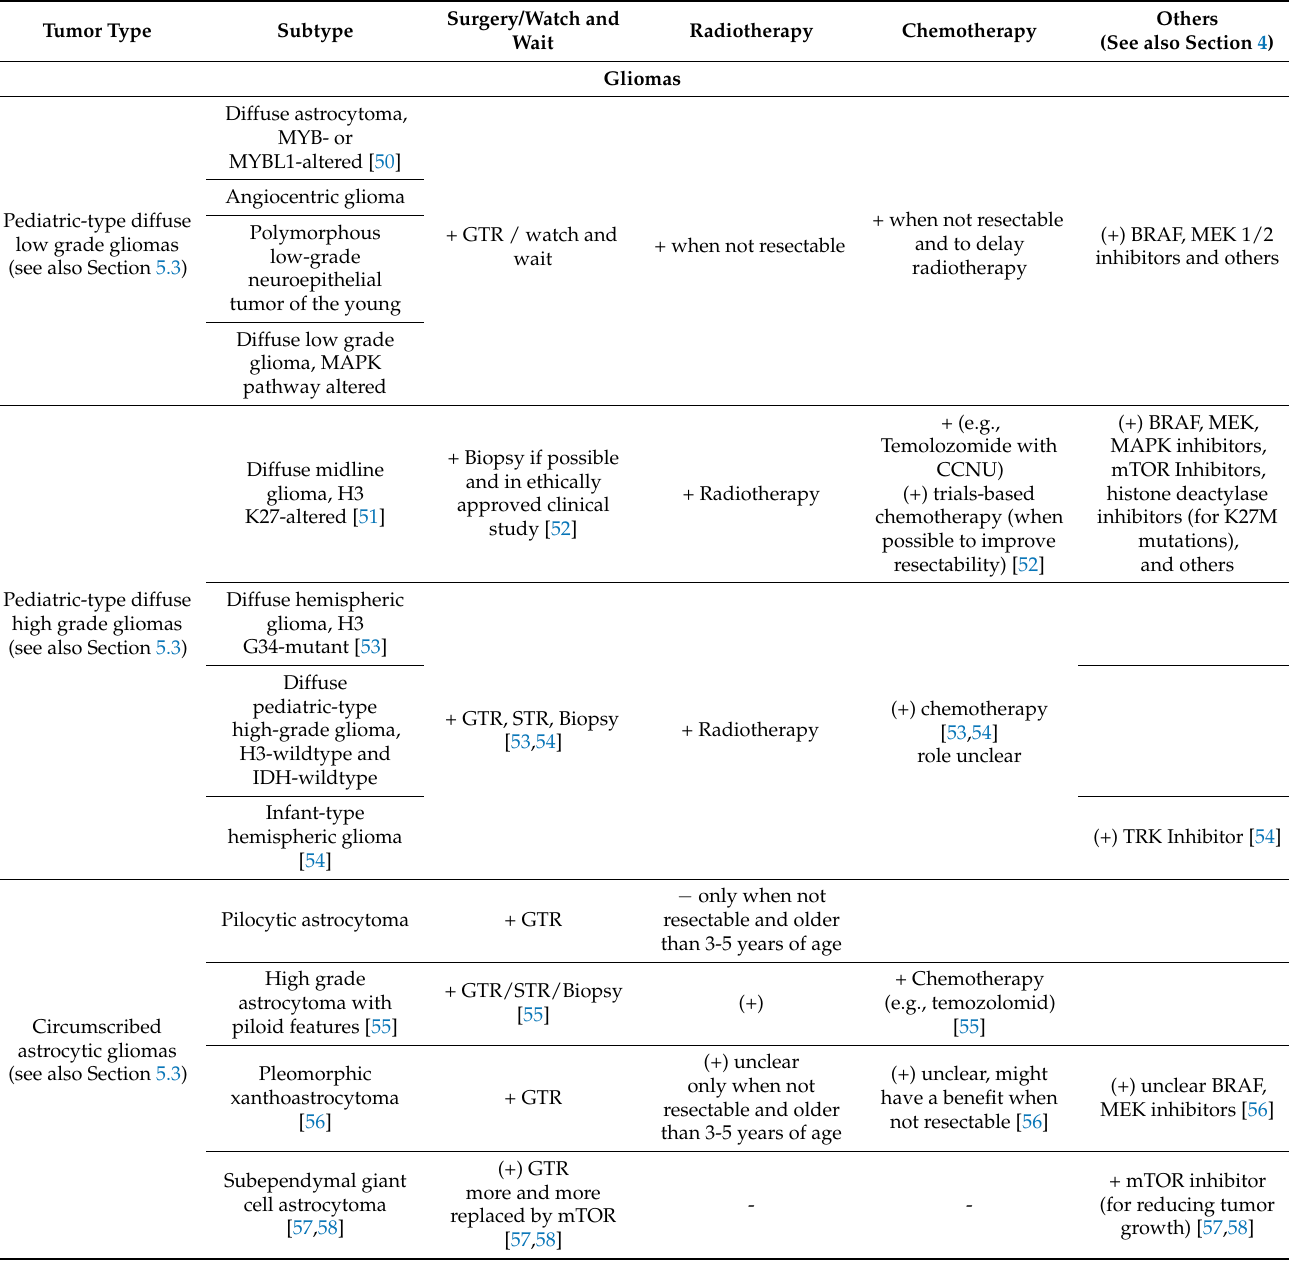
Table 2. Tumor subgroups according to the 5th WHO classification and recommended treatment (no claim to completeness, data for rare tumor entities only base on case series/reports) [2,4,7,49]. By permission of Oxford University